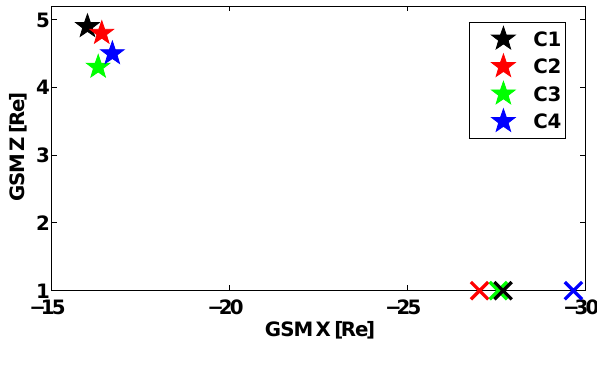
Fig. 6. Cluster spacecraft arrangement (star markers) and recon- structed locations of X-line (cross markers).